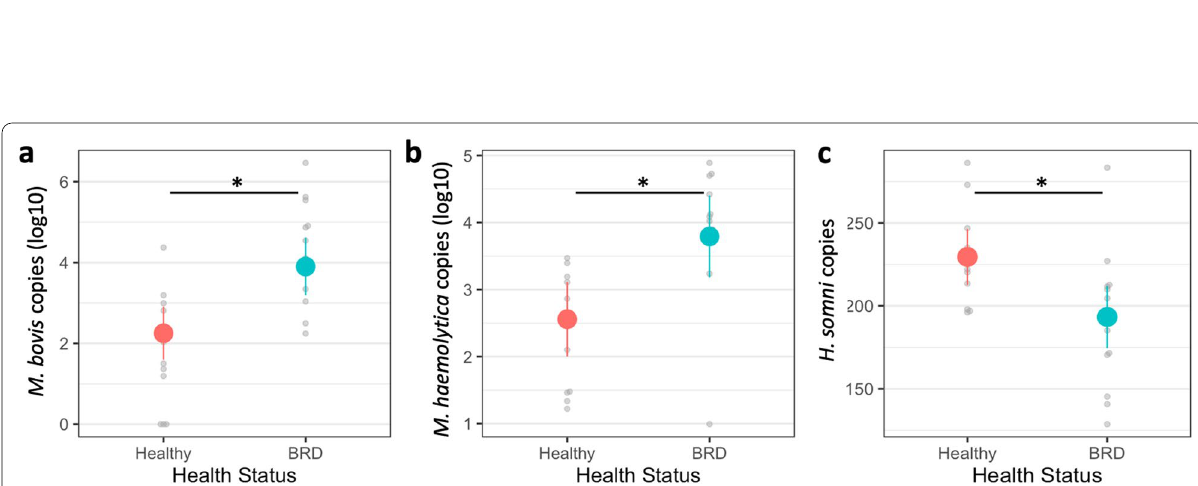
Fig. 5 Difference in bacterial abundance per sample (200 µl of extracted DNA) for Mycoplasma bovis ( a) , Mannheimia haemolytica ( b) and Histophilus somni ( c ) between animals with (BRD) and without (Healthy) BRD clinical signs (n statistical difference ( p 0.05) between the two groups. Colored circles represent the means of the BRD, and healthy group, vertical lines indicate ≤ the standard error of the means, and the gray dots represent individual samples of each